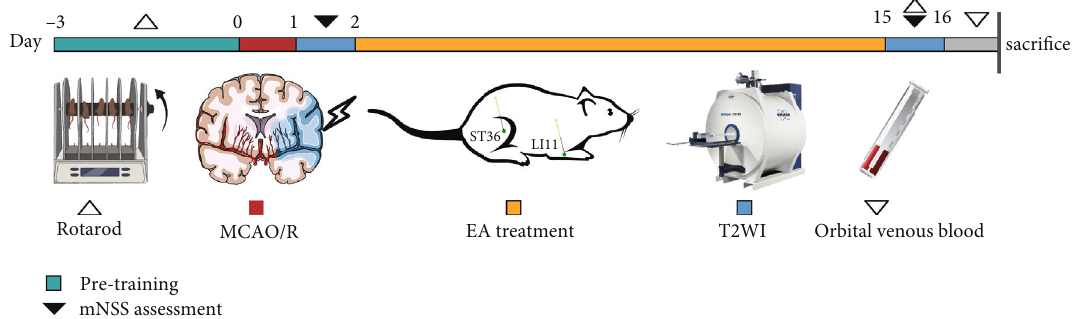
Figure 1: Testing timeline. Abbreviations: EA: electroacupuncture; MCAO/R: middle cerebral artery occlusion-reperfusion; mNSS: modi fi ed neurological severity score; and T2WI: T2-weighted